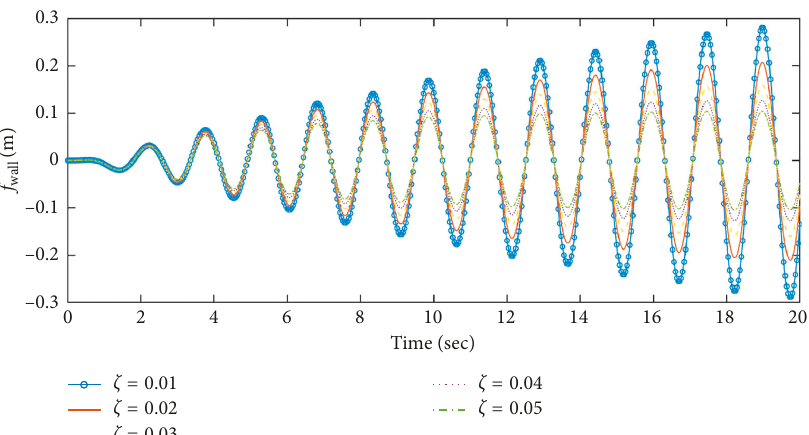
Figure 10: The resonant time histories of the surface wave height on the wall ( θ � 0) for z